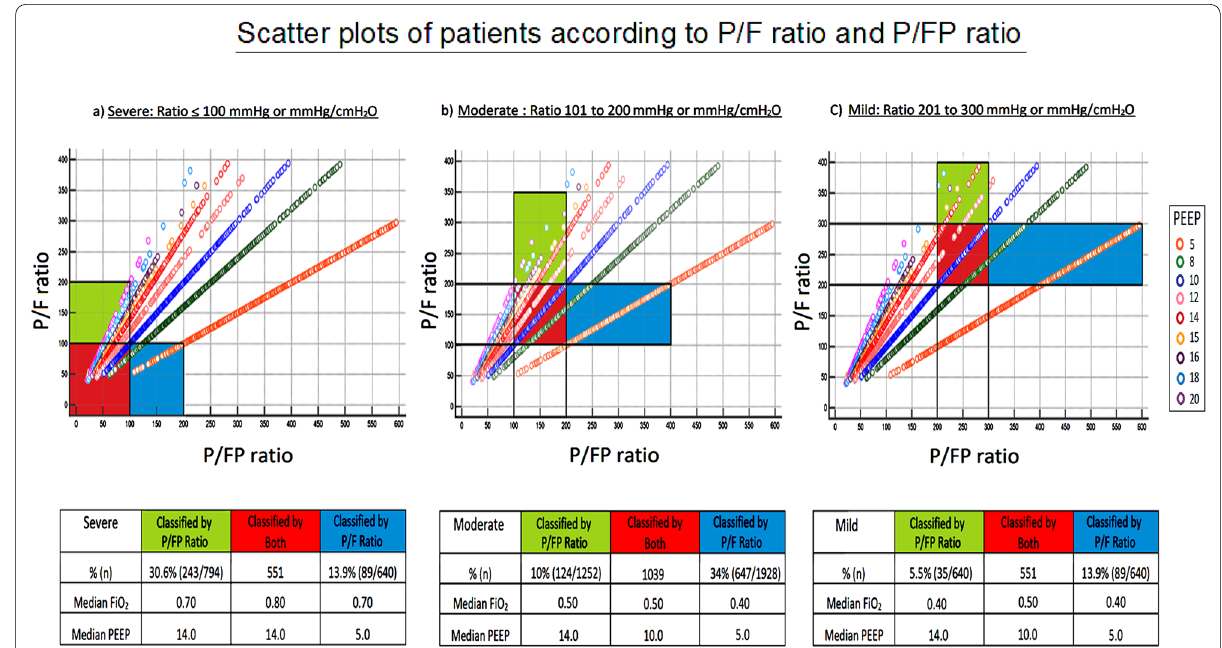
Fig. 2 Scatter plots of patients according to P/F ratio and P/FP ratio. Each circle represents individual patients on a certain applied PEEP; each colour represents a different PEEP setting. Green bars represent patients who were classified by the P/FP ratio in each severity. Blue bars represent patients who were classified by the P/F ratio in each severity. Red bars represent patients whose categories remained unchanged. Definition of abbreviations: FiO 2 fraction of inspired oxygen; PEEP positive end-expiratory pressure; P/F ratio of the partial pressure of arterial oxygen (PaO 2 ) = = = to FiO 2 ; P/FP (PaO 2 * 10)/(FiO 2 * =